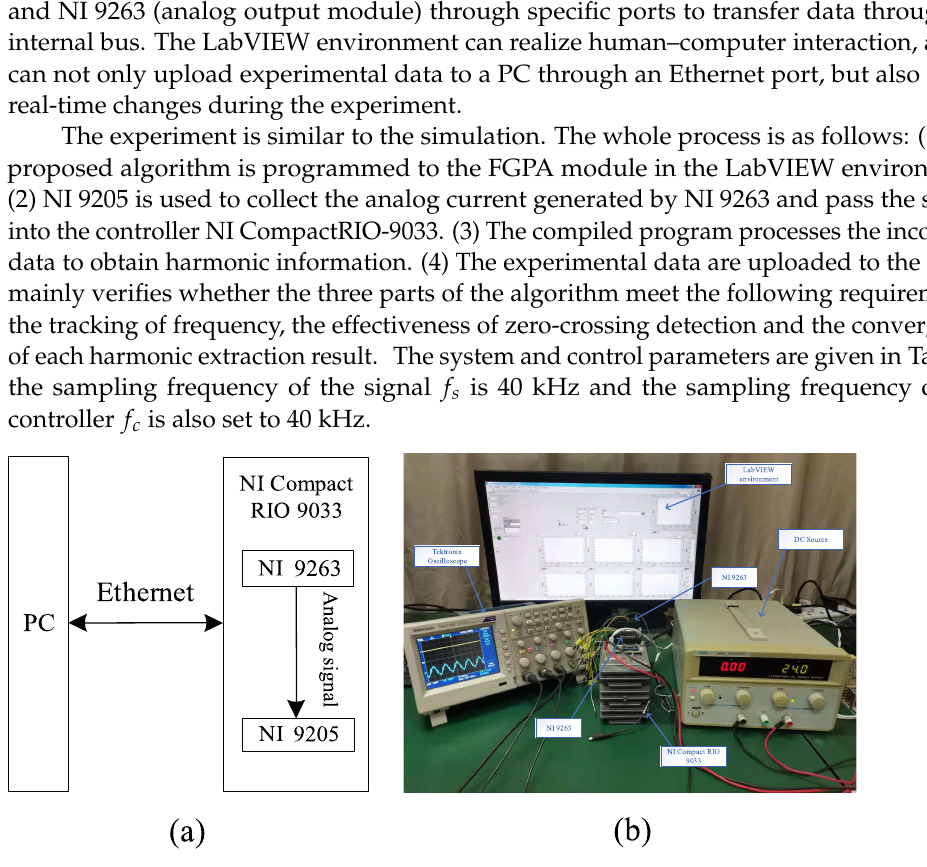
Figure 14. The test platform. ( a ) block diagram. ( b ) experimental test